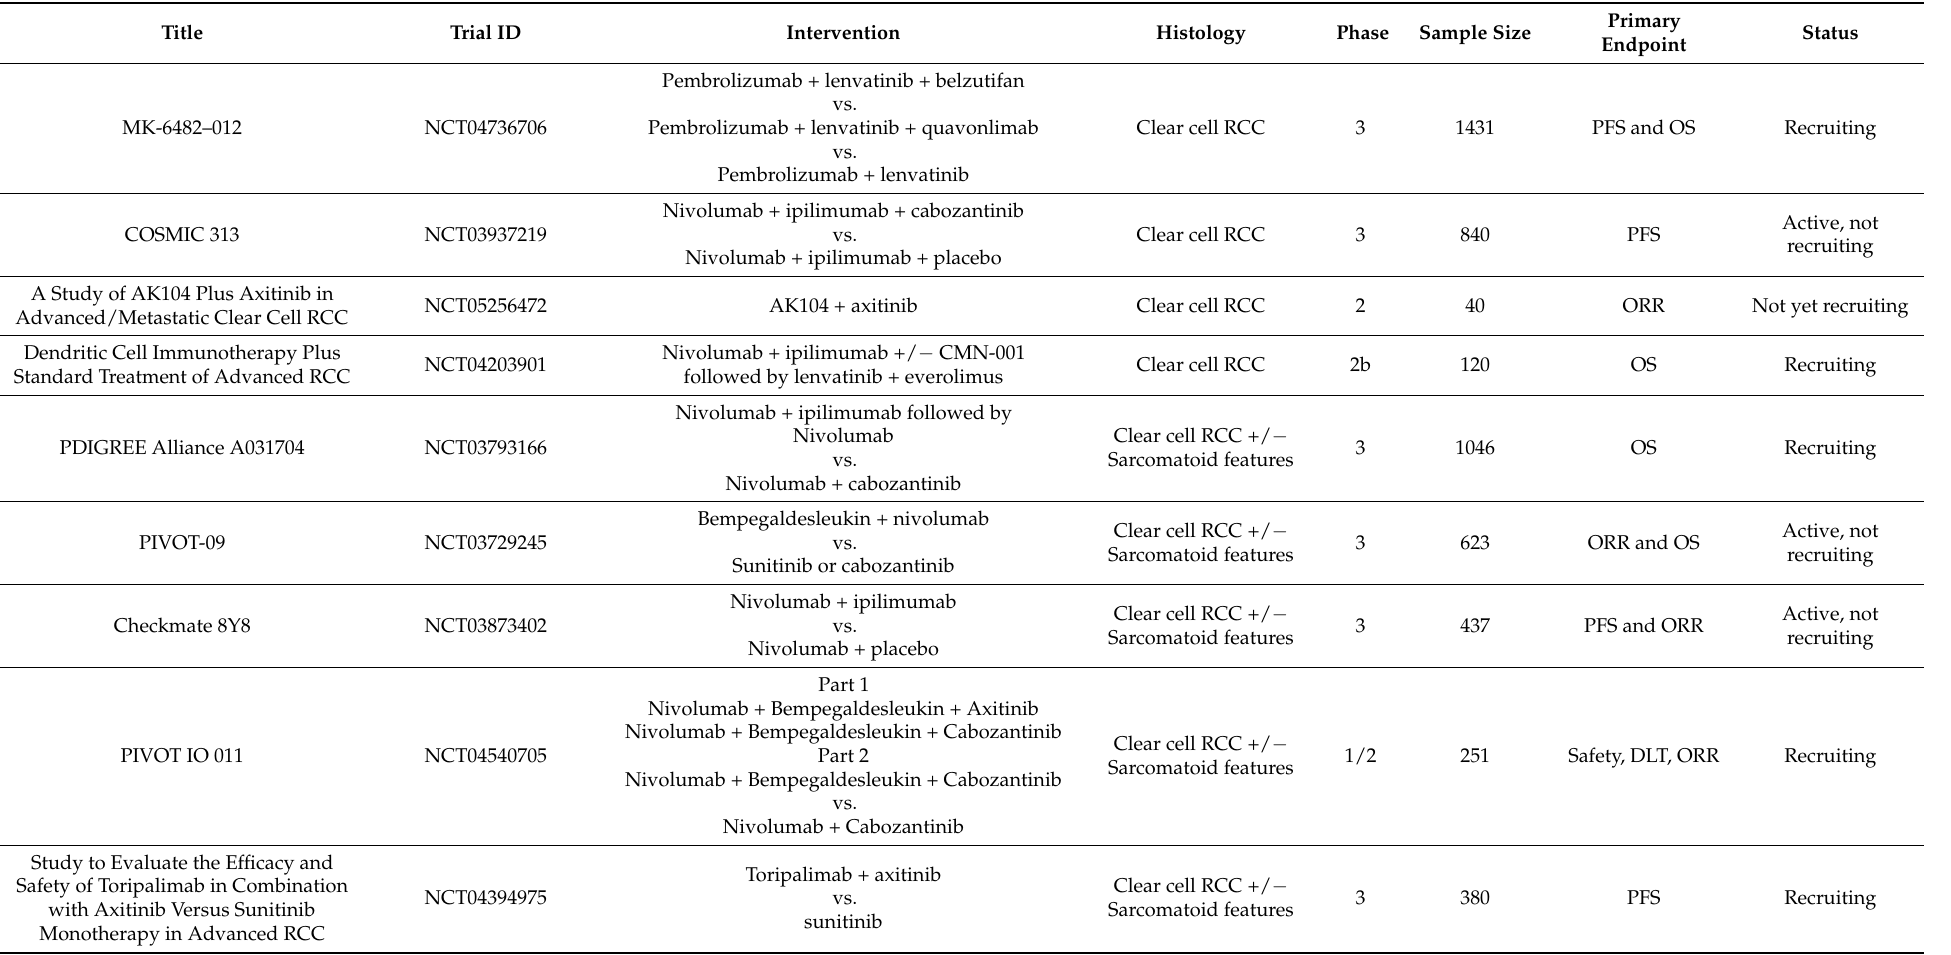
Table 2. Ongoing front-line trials in renal cell